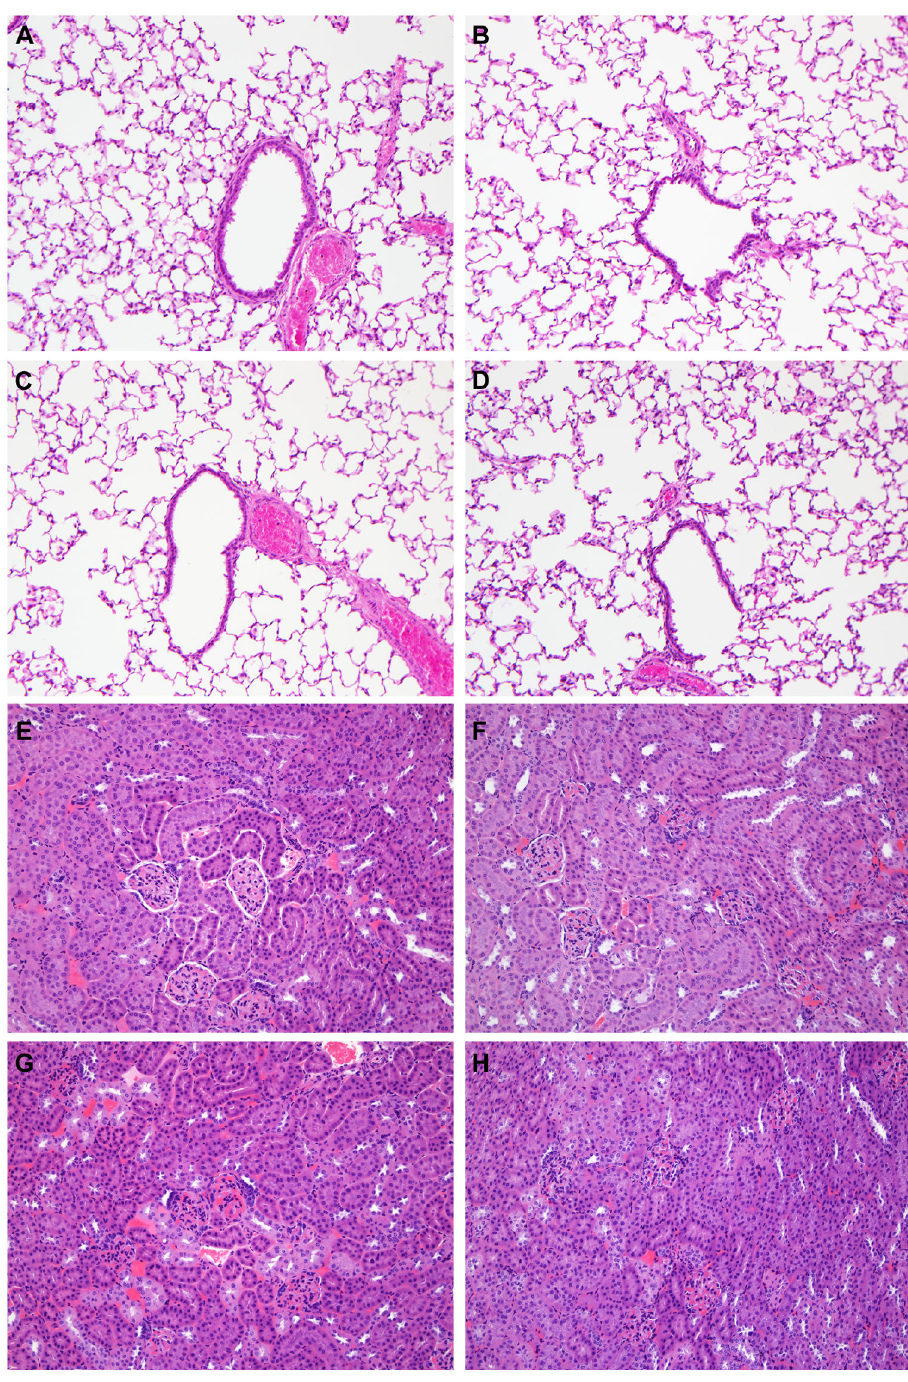
Figure 2. Histological analysis of lungs and kidney of Syrian hamsters inoculated with MERS-CoV isolate HCoV-EMC/2012.